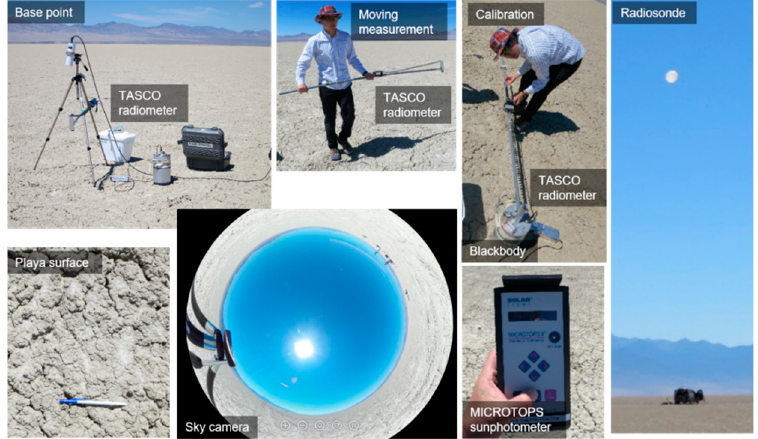
Figure 4. Photos from the VC experiment conducted in Railroad Valley Playa on 31 August 2018.